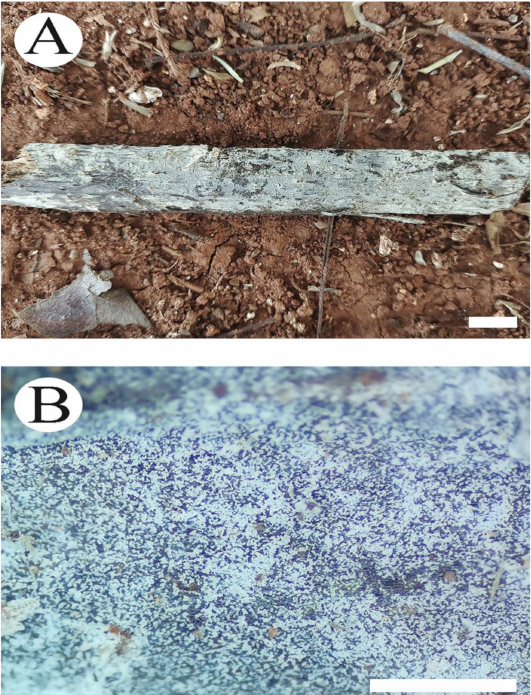
Figure 7. Basidiomata of Trechispora olivacea (holotype CLZhao 17826): the front of the basidiomata ( A ), characteristic hymenophore ( B ). Bars: ( A ) = 1 cm and ( B ) = 1 mm.